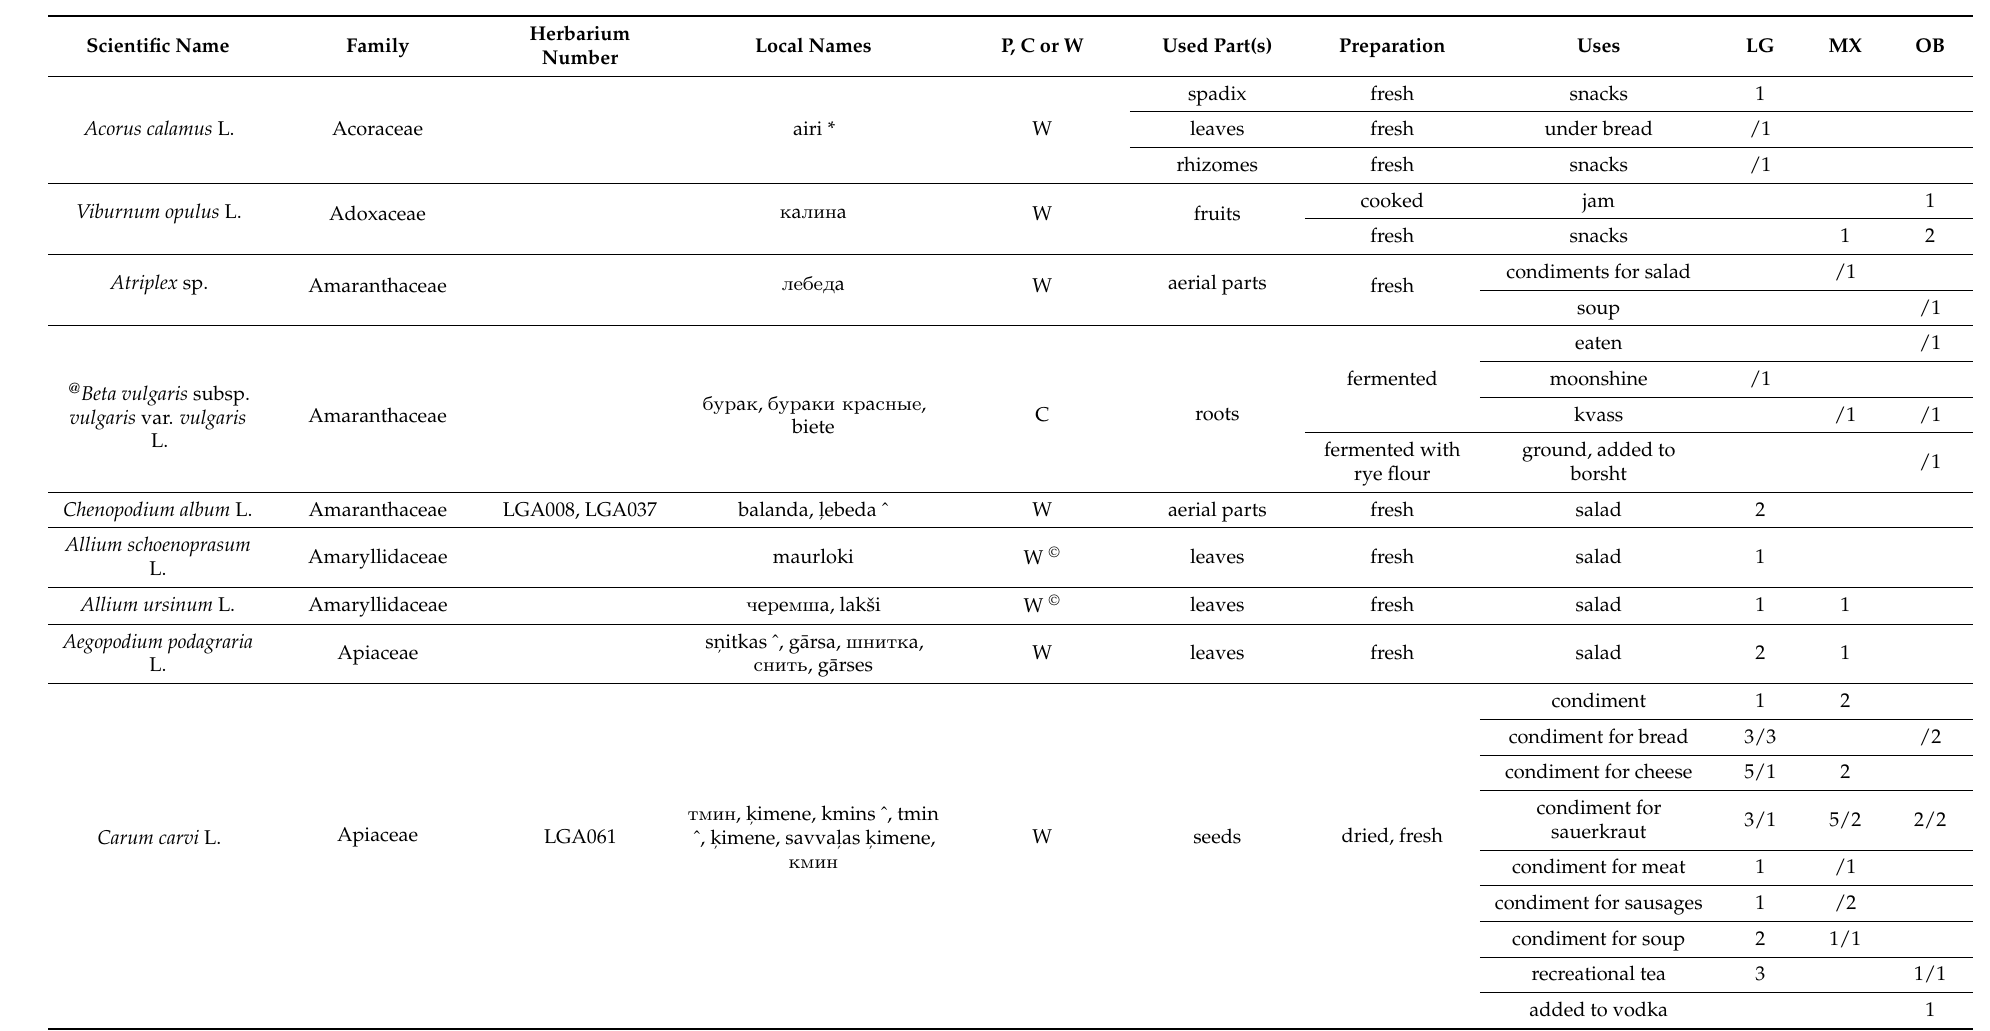
Table 2. Food uses of plants in Dagda